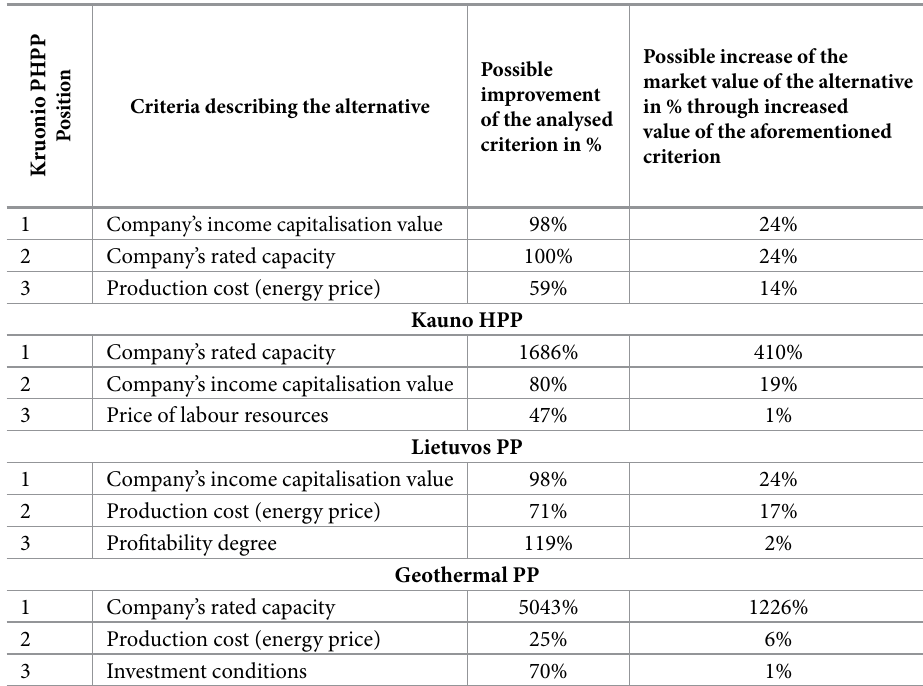
possible improvement of the analysed criterion in %